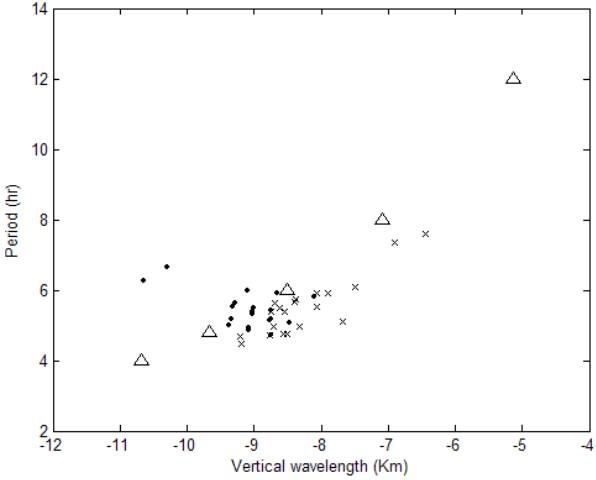
Fig.4 Period vs. vertical wavelength plot of the component waves in Table 2a (by upward triangle ) Fig. 4. Period vs. vertical wavelength plot of the component waves and the investigations of wave packets such as that in Fig.7 by phase and group velocity tracing 10 in Table 2a (by upward triangle) and the investigations of wave technique (by cross ). When all the component waves in Table 2a propagate in same direction with packets such as that in Fig. 7 by phase and group velocity tracing azimuth of 20 degrees (Table 2c), the velocity tracing investigations of the corresponding wave technique (by a cross). When all the component waves in Table 2a propagate in same direction with azimuth of 20 degrees (Table 2c), packets were presented by ‘ dot’. the velocity tracing investigations of the corresponding wave pack- ets were presented by a “dot”.